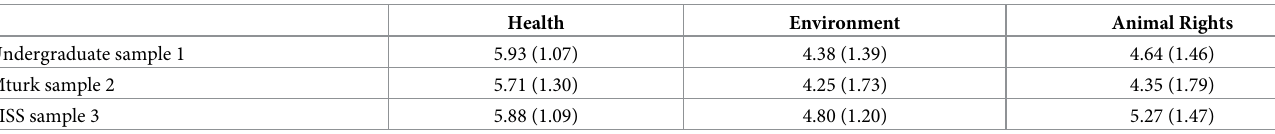
Table 3. Means and standard deviations for VEMI scales in three